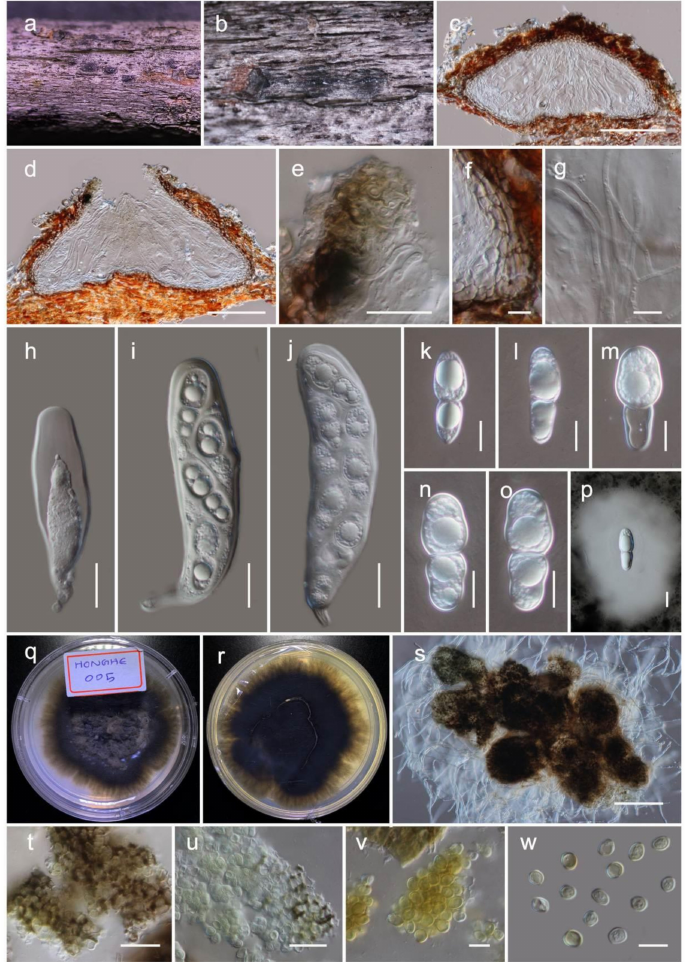
Figure 5. The sexual (HKAS110128, holotype) and asexual (KUMCC 20-0220, ex-type) morphs of Haniomyces dodonaeae . ( a,b ) ascomata on the dead woody twigs of Dodonaea viscosa ; ( c,d ) vertical section of ascoma; ( e ) periphyses; ( f ) peridium; ( g ) pseudoparaphyses; ( h – j ) asci; ( k – p ) ascospores ( p in Indian Ink); ( q,r ) colony on potato dextrose agar (PDA) ( r from the bottom); ( s ) squashed pycnidia which were produced on PDA; ( t ) pycnidia wall; ( u – w ) conidia. Scale bars, ( c,d ) 100 µ m; ( e,h – j,t,u ) 20 µ m; ( f , k – p,v,w ) 10 µ m; ( s ) 200 µ